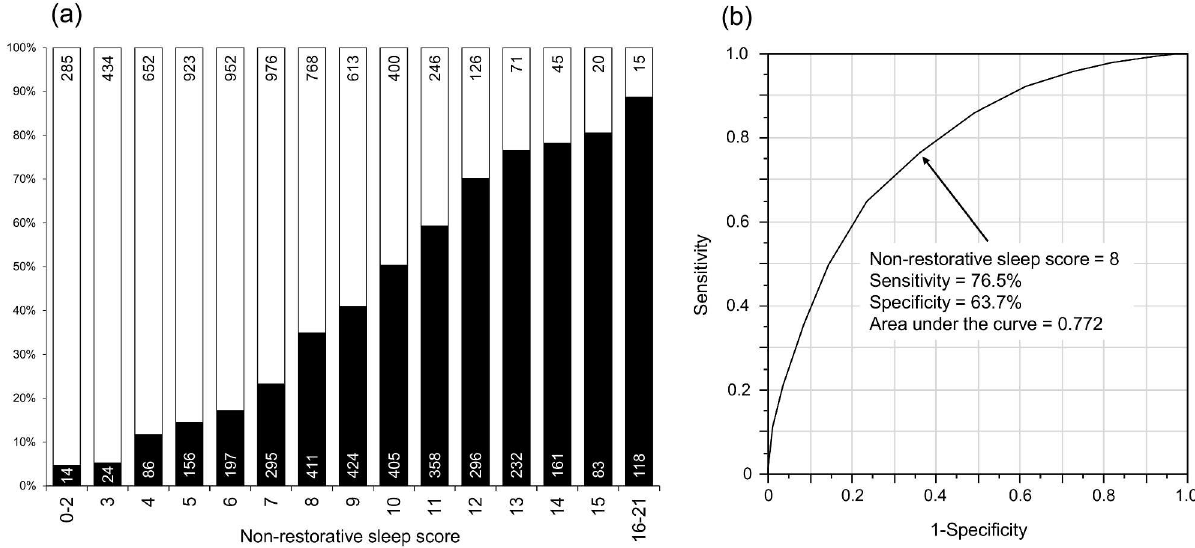
Fig 2. Frequency differences in subjective NRS according to the NRS score. ■ : non-restorative sleep (NRS); □ : restorative sleep. (a) frequencyof NRS, (b) receiver operatingcharacteristics curve for subjectiveNRS. Number of individuals is shown within